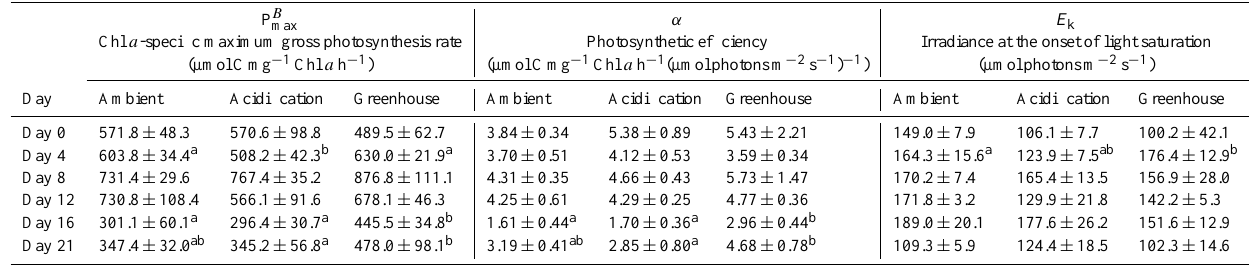
Fig. 3. Photosynthesis-irradiance (P-I) curves obtained by in situ incorporation of 14 C during the experimental period in the ambient (green), acidification (blue), and greenhouse (red) treatment conditions. Error bars represent the standard deviation from the mean of replicate deter- minations ( n = 3). Table 2. Photosynthetic parameters from photosynthesis-irradiance (P-I) curves of the phytoplankton community obtained by the 14 C uptake experiment. Different letters indicate a significant difference based on Tukey’s multiple comparison ( p